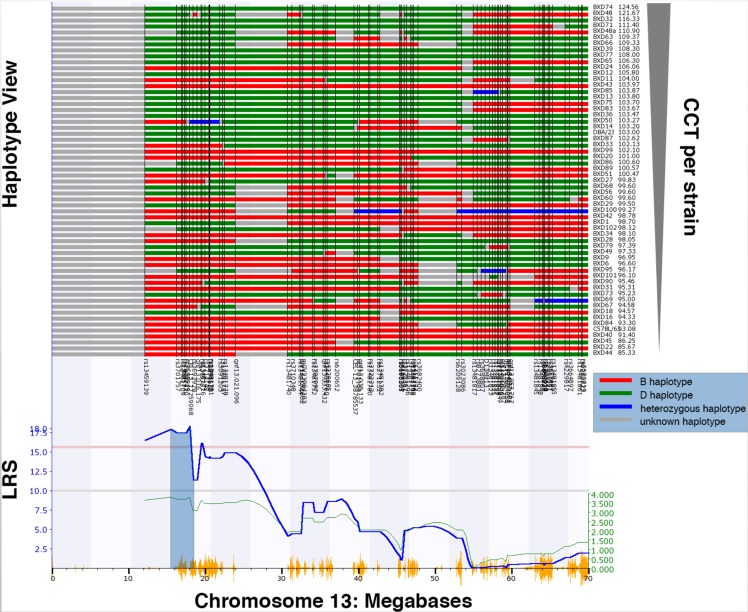
Map of gene locations across Chr. 13.The haplotype map for the 61 strains in the CCT dataset is shown in the top panel. As indicated at the key on the right, red represents the B6 alleles, green defines the D2 alleles, blue represents regions of the DNA that are heterozygotic and gray is unmapped. The genomic markers used in the mapping process are listed at the bottom of the haplotype map. At the far right is a list of the specific BXD RI strains and the associated CCT measurements going from thick corneas at the top to thin corneas at the bottom. QTL map of CCT on Chr. 13 is shown below the haplotype map. An LRS of above the pink line is statistically significant (p<0.05). A positive additive coefficient (green line) indicates that D2 alleles are associated with higher trait values. The light fill under the peak defines the genomic locus associated with the modulation of CCT. The significant peak for CCT is from 13 to 19 Mb (gray shaded area). Vertical orange lines at the bottom of the plot show the SNPs on Chr. 13.